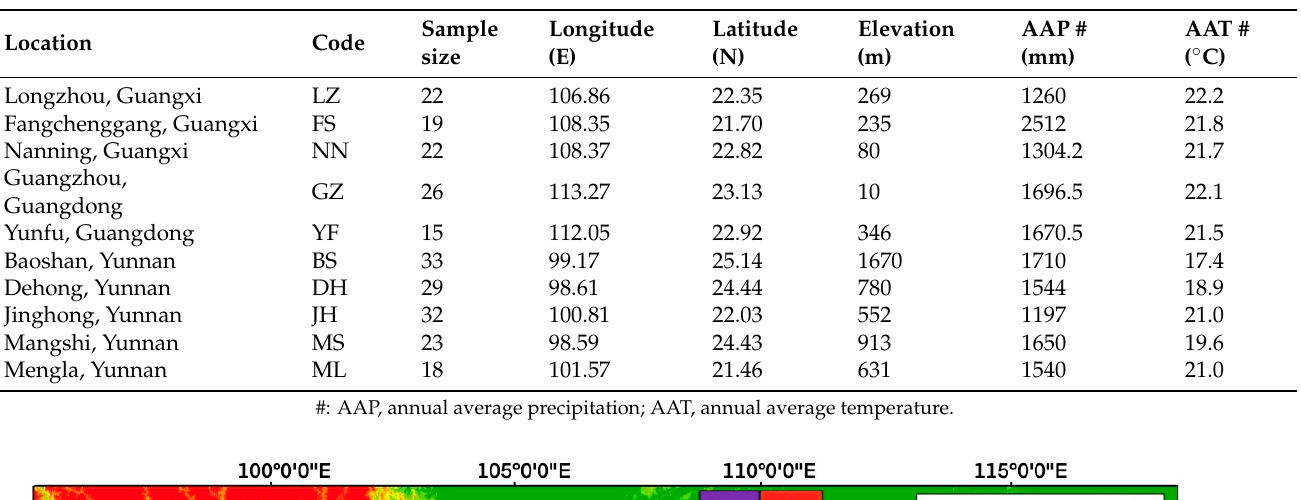
Table 1. Locations, sample sizes, and two climatic factors of ten populations of N. cadamba from China.